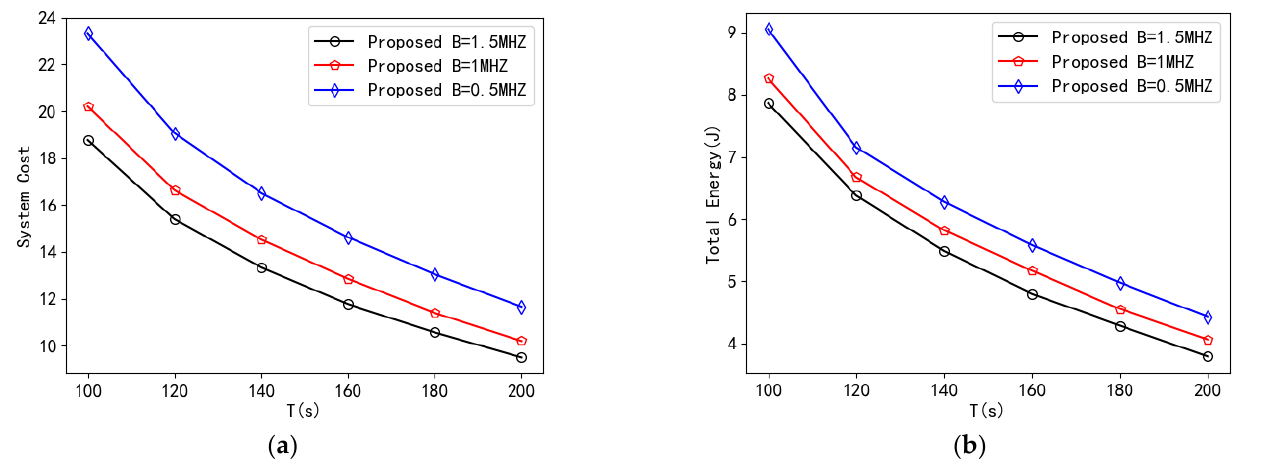
Figure 6. Total bandwidth Influence on Total System Cost and Total Energy Consumption: ( a ) total system cost; ( b ) total energy consumption of users.